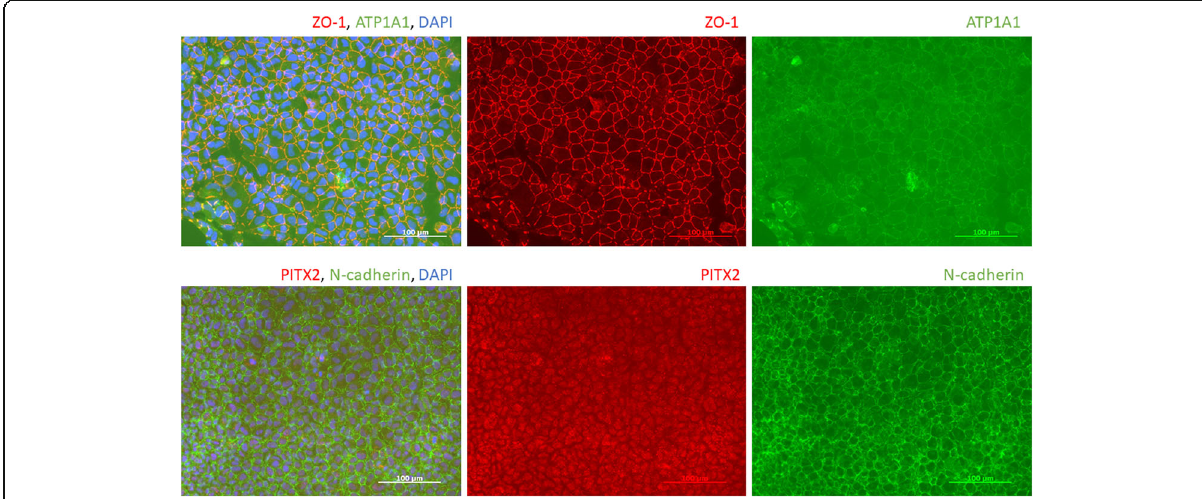
Fig. 2 Corneal endothelial-like cell from our lab. Na,K-ATPase alpha-1 subunit (ATP1A1), ZO-1, and N-cadherin express on the cell border, and PITX2 express on cell